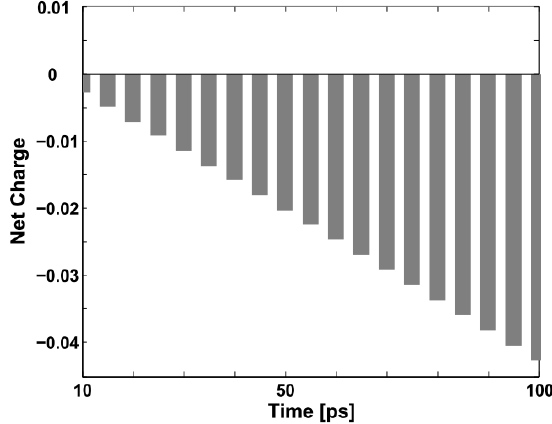
Figure 6. Net charge variation of the triplet exciton within the first 100 ps (the unit on the vertical axis is